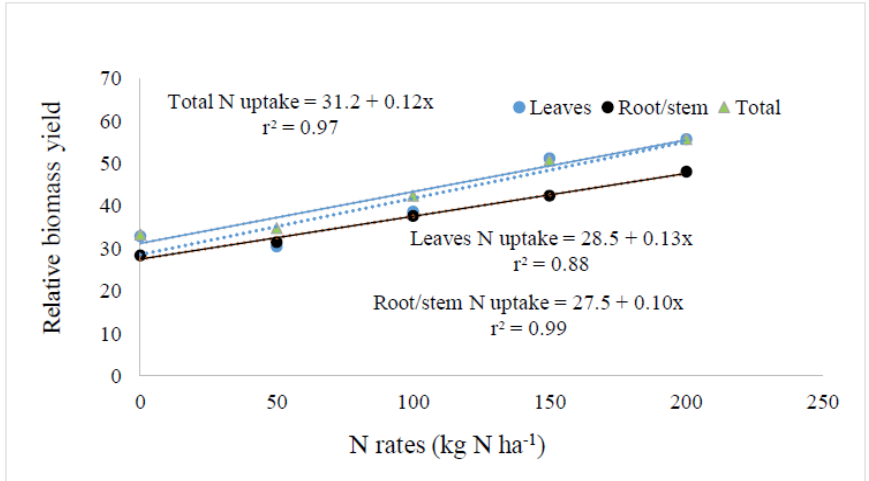
Figure 4. Regression model for relative leaf, root / stem, and leaf + root / stem total nitrogen (N) of swede and kale averaged, a ff ected by di ff erent N rates averaged across three environments in Prosper and Walcott, ND, USA in 2012 and 2014.